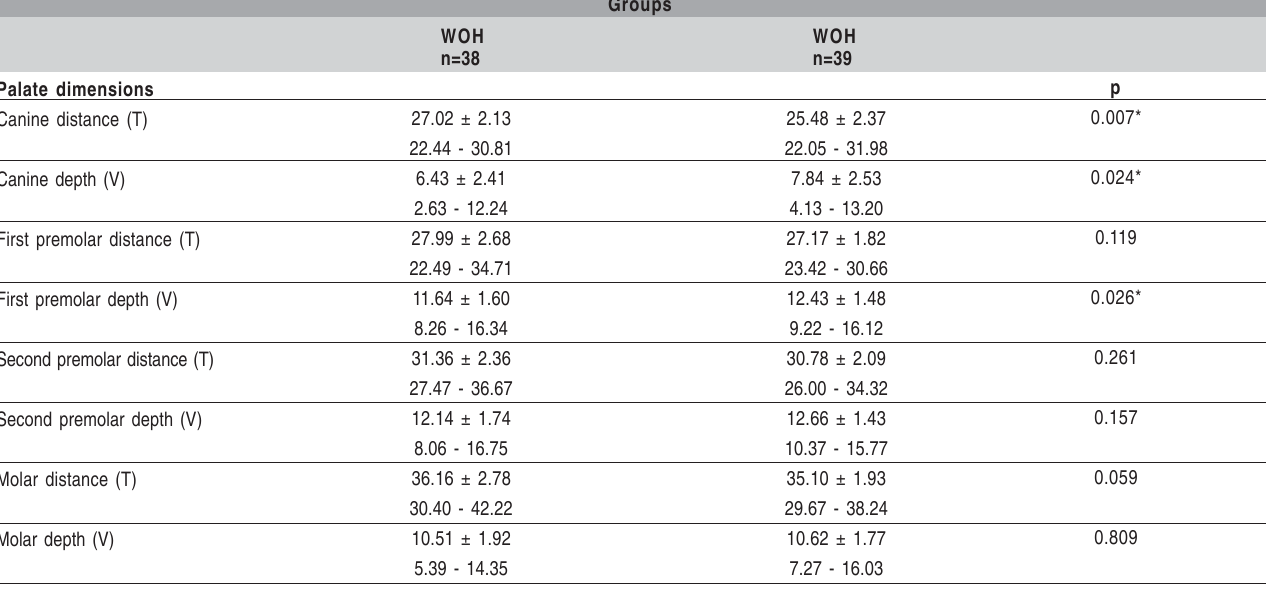
*Student’s t-test (p< 0.05); WOH=without prolonged habits; WH=with prolonged habits. Table 3: Comparative results of mean and standard-deviation ( ± S), minimal and maximal values (X (T) and Vertical (V) palate dimensions considering the presence the nonnutritive sucking habits and respiratory mode.